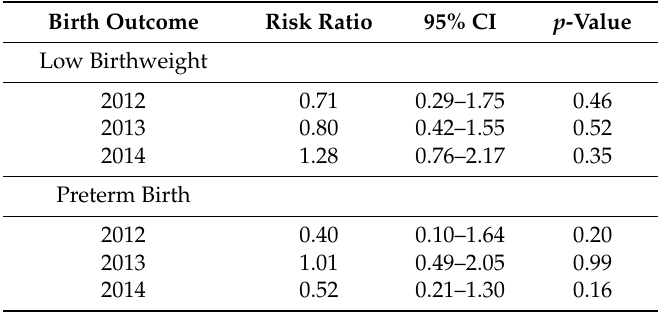
Table 2. Post- versus pre-disaster risk ratios of low birthweight and preterm birth, adjusted for maternal age and neonatal sex.